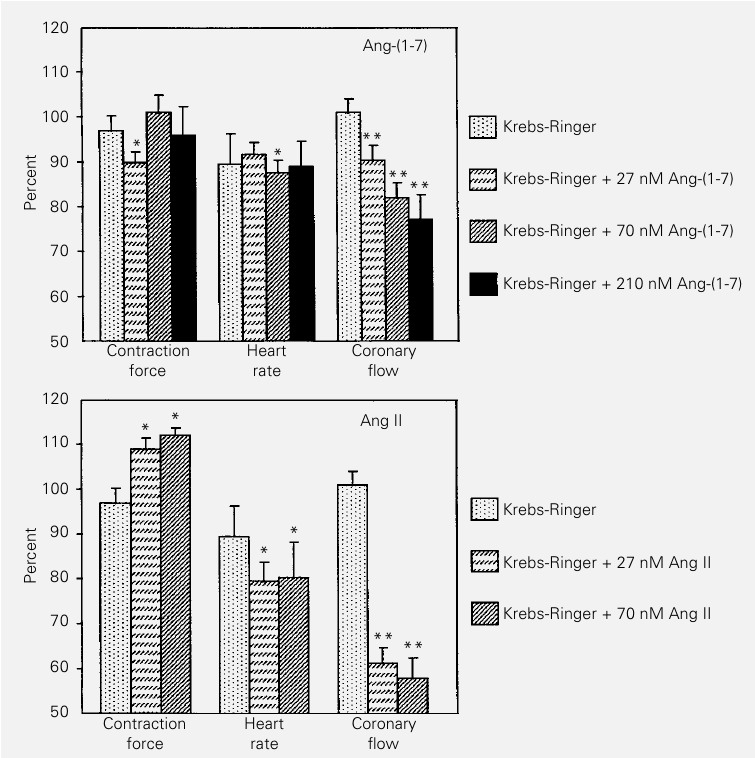
Figure 1 - Contraction force, heart rate and coronary flow in isolated rat hearts perfused with 1) Krebs-Ringer solution (control, N = 9); 2) Krebs-Ringer solution containing Ang-(1-7) concentrations of 27 nM (N = 9), 70 nM (N = 9), or 210 nM (N = 3) and 3) Krebs-Ringer solution containing Ang II concentrations of 27 nM (N = 11), or 70 nM (N = 6). *P<0.05 compared to the end of the equilibration period (Student t -test for paired observations). **P<0.05 compared to the end of the equilibration period and the control group (Student t - test for paired observations and ANOVA followed by the Newman-Keuls